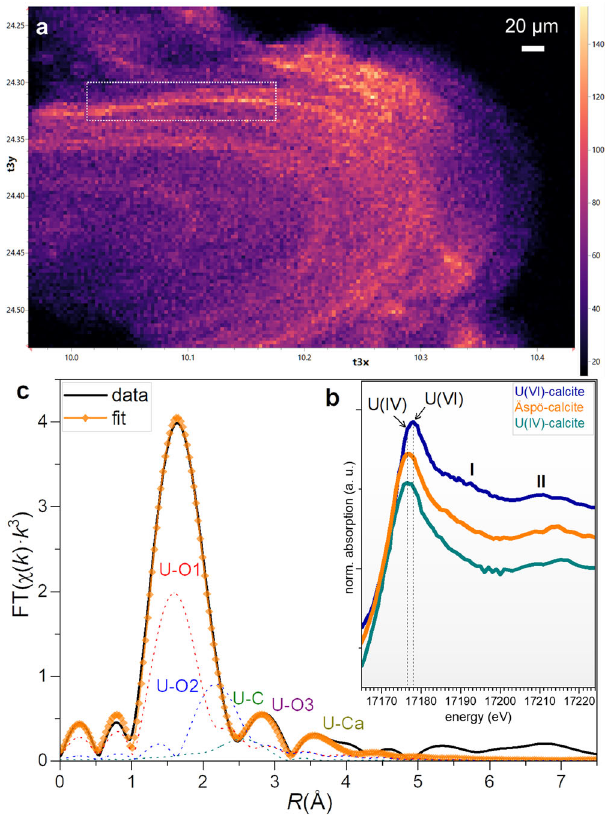
Fig. 1 µ XRF and µ XAS results. a U µ XRF map of a calcite crystal from Äspö HRL. The area outlined with a dashed line was used for U L III -edge XANES measurements (estimated ~20 ppm U 13 , on the right y-axis - relative signal intensity scale); b U L III -edge µ XANES spectra of Äspö-calcite, U(IV)- calcite 11 and U(VI)-calcite 20 . The energy shift between U(IV) and U(VI) references is ~1.6 eV. Marked on the spectrum of ‘ U(VI)-calcite ’ with I and II are spectral features characteristic to uranyl(VI) species; c Magnitude of the Fourier-transformed EXAFS (black solid line) and best fi t (colored rhombs) for the “ Äspö-calcite ” and single scattering paths for the fi tted shells (see further details in SI and Supplementary Fig. 2c, d for k 3 -weighted and the real part EXAFS